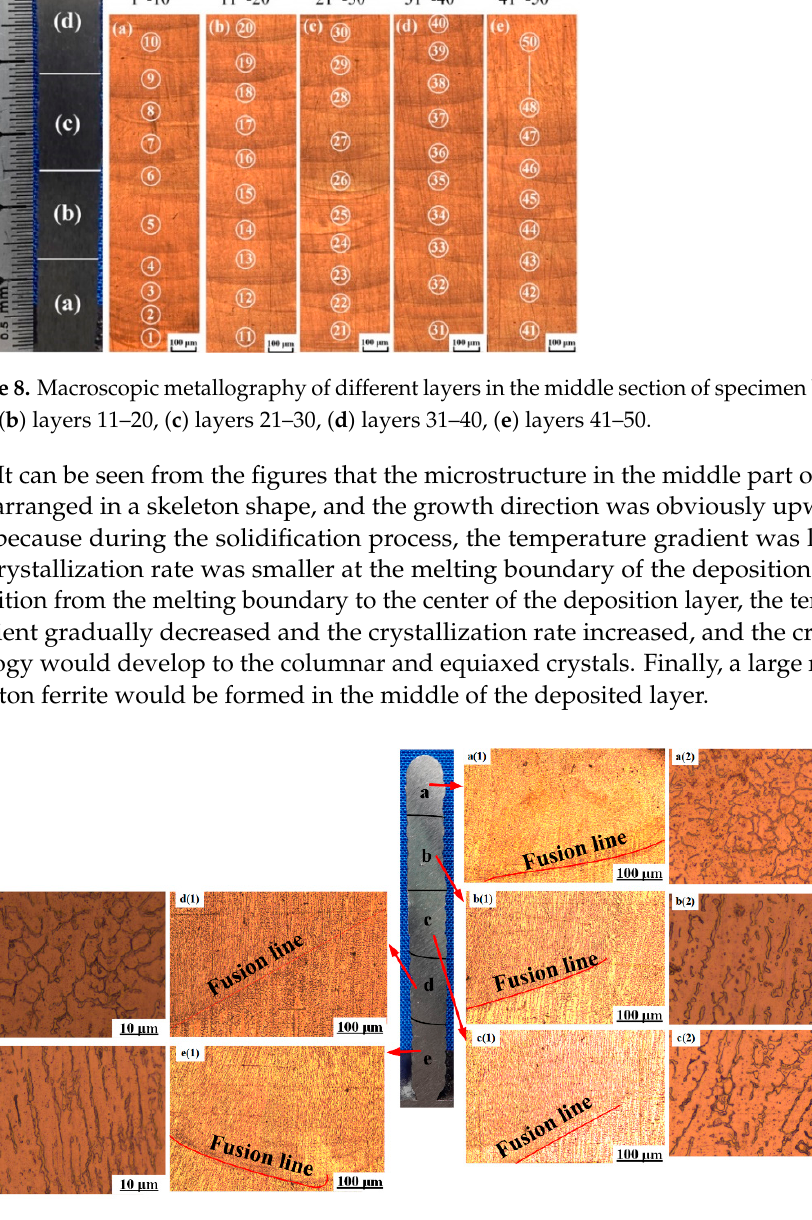
Figure 8. Macroscopic metallography of different layers in the middle section of specimen B: ( a ) layers 1–10, ( b ) layers 11–20, ( c ) layers 21–30, ( d ) layers 31–40, ( e ) layers 41–50.